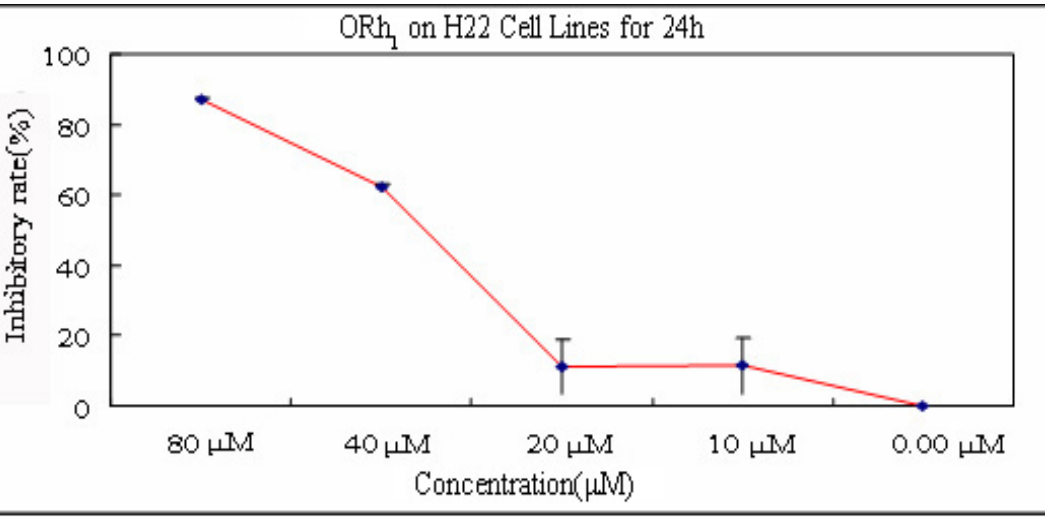
Figure 4. The rate of inhibition of ORh